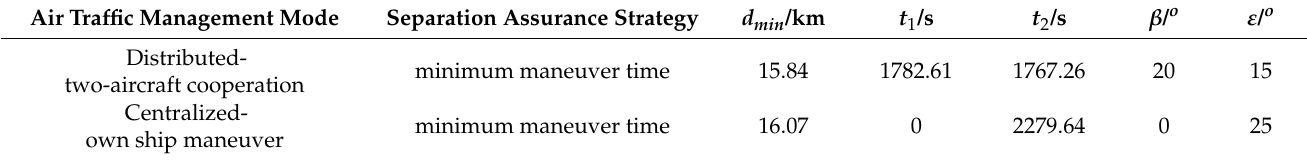
Table 5. Comparison experiment of the two air traffic management